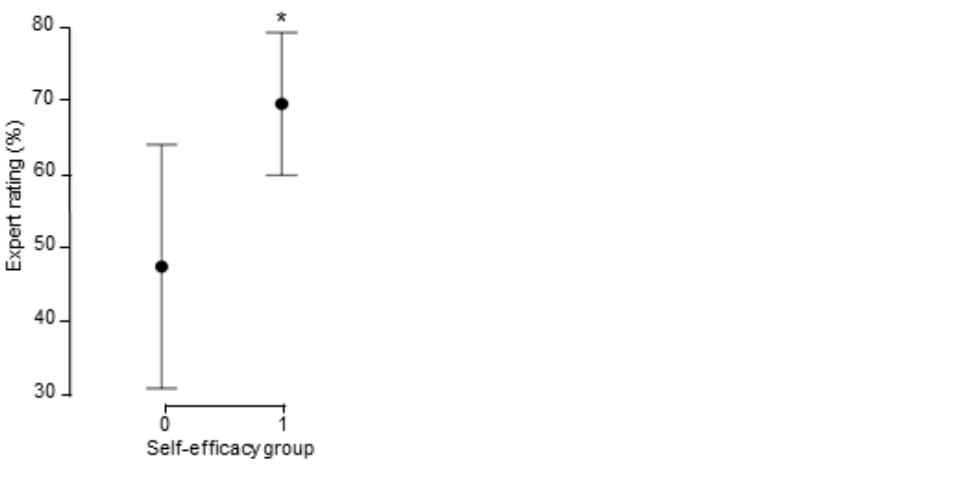
Figure 1. Group differences in self-efficacy change and expert ratings. The data are presented as means with 95% CI error bars. The self-efficacy group 0 represents the respondents with a negative change in self-efficacy, while group 1 represents the respondents with a positive change. * indicates a significant higher mean value at 0.05 level.